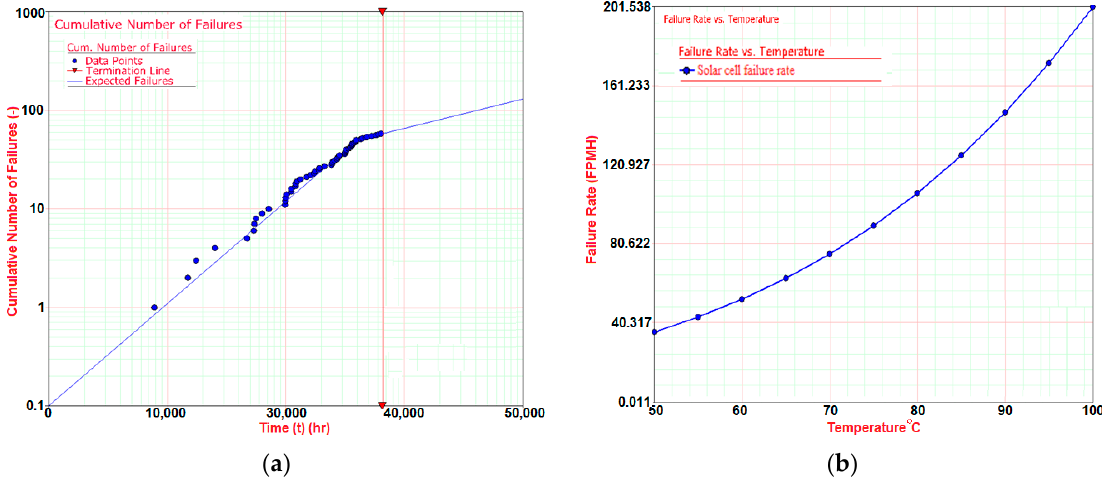
Figure 17. ( a ) Cumulative number of failures as function of time (using ALTA module). ( b ) Baseline survival of solar cell simulation (using ALTA module) in temperature and stress conditions.